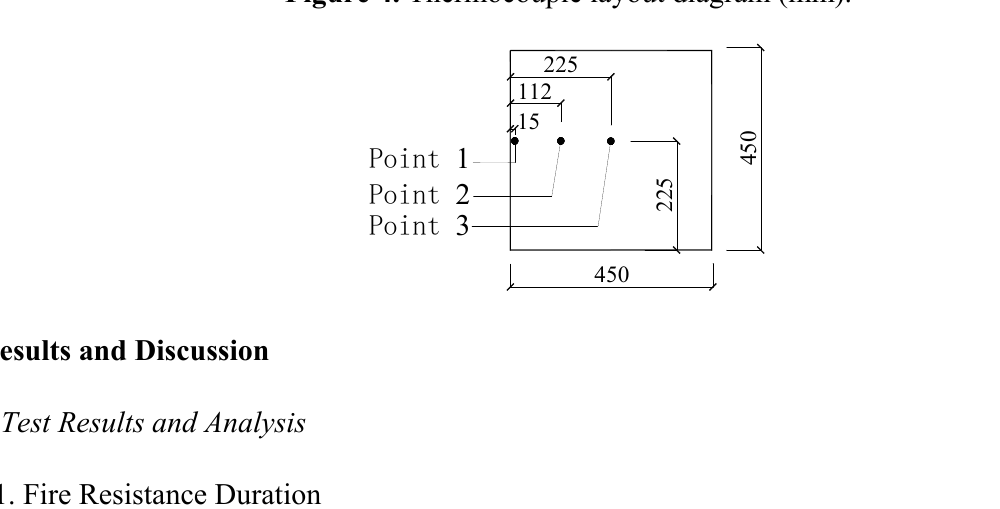
Figure 4. Thermocouple layout diagram